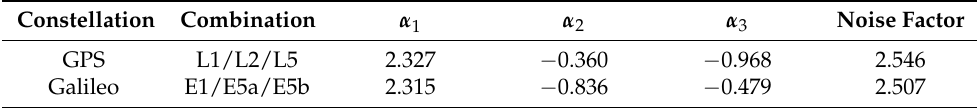
Table 2. Triple-frequency combinations, their coefficients and noise amplification factors [40].